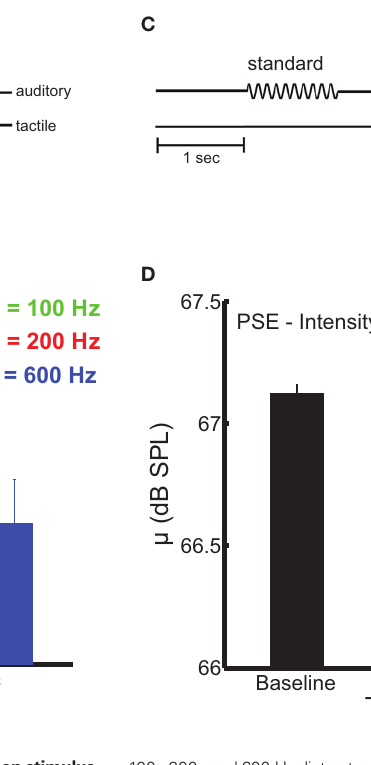
100-, 200-, and 600-Hz distractors, respectively). The black bar shows the PSE in the baseline condition. Error bars indicate SEM. The frequency bias effects were comparable across the synchronous and asynchronous timing conditions. (D) Mean bias estimates on the intensity discrimination task as a function of stimulus timing. Conventions as in (C) . Intensity bias effects depended on synchronous presentation of auditory stimuli and tactile